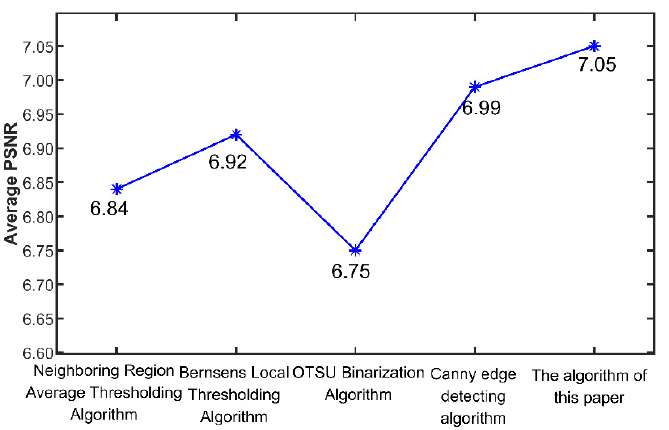
Figure 20. Comparison of the average peak signal-to-noise ratio of different edge detection thresh- old algorithms.